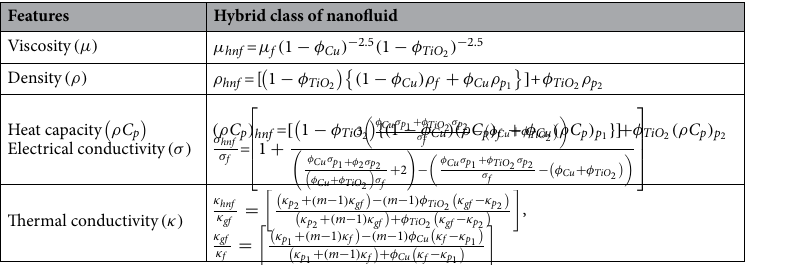
Table 2. Thermo-physical aspects of hybrid class of nanofluid.